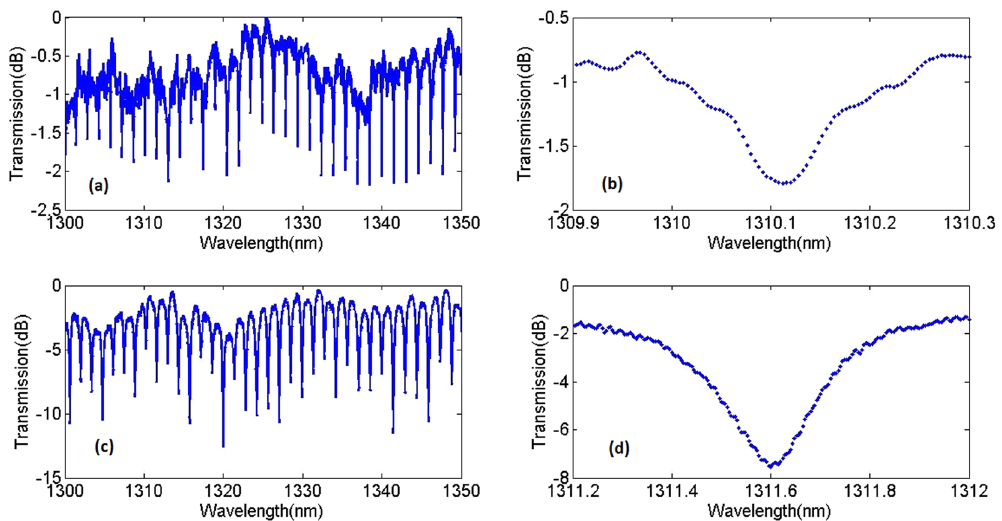
Figure 3. ( a ) Measured transmission spectrum at 1310 nm for a ring resonator with R = 50 µ m and G = 200 nm for the quasi – TE mode of 400 nm × 450 nm waveguide. ( b ) Spectrum of a single resonance. ( c ) Measured transmission spectrum at 1310 nm for a ring resonator with R = 50 µ m and G = 200 nm for the quasi – TM mode of 400 nm × 450 nm waveguide. ( d ) Spectrum of a single